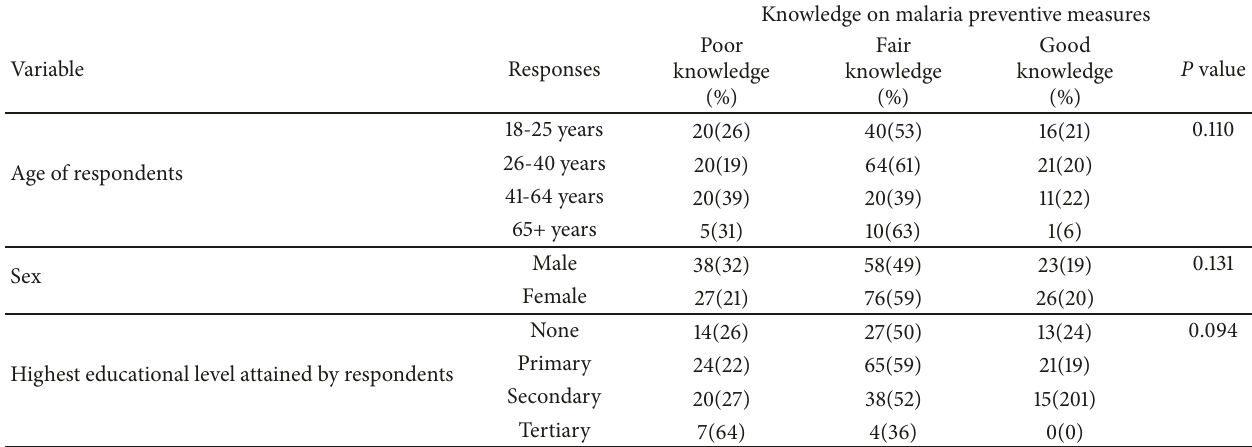
Table 5: Association between knowledge of malaria preventive measure and demographic